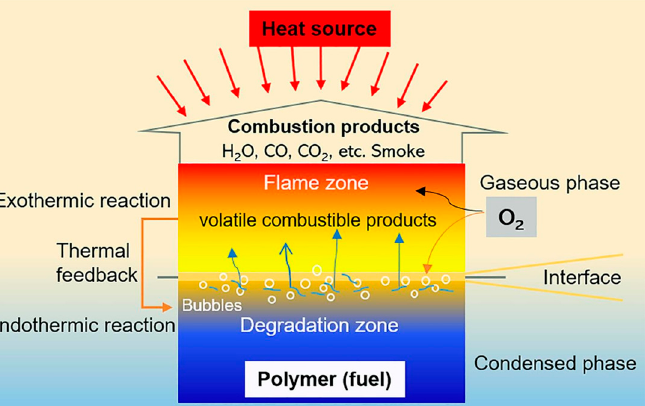
Figure 7. Representation of the combustion process of polymeric materials. Reprinted with permis- sion from Ref. [102]. Copyright 2020, W. He, Progress in Materials Science, Elsevier.